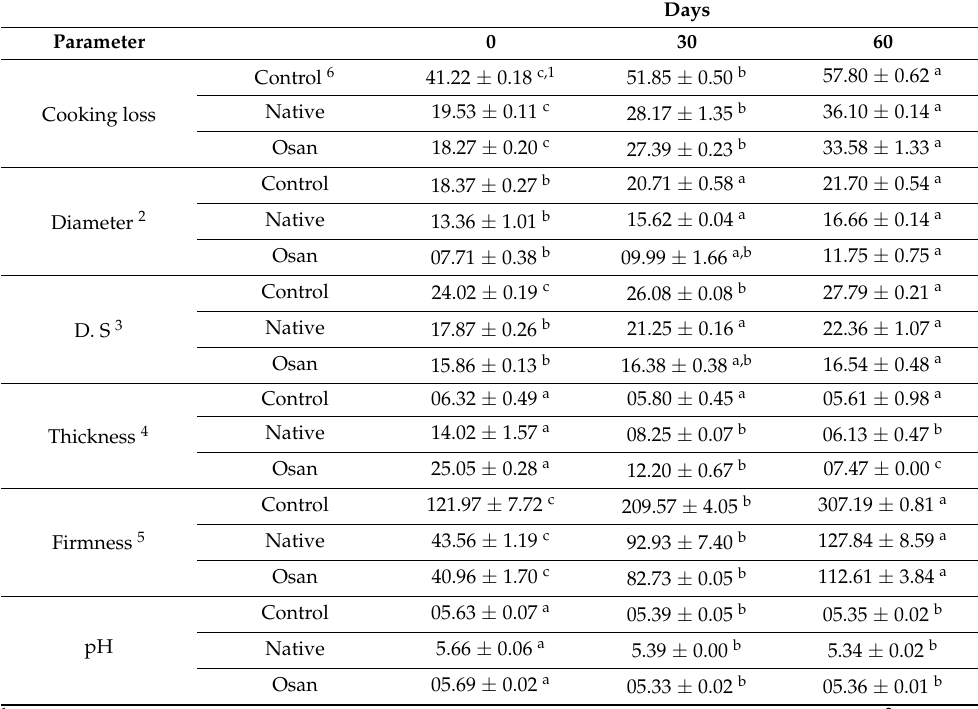
Table 2. Effect of 5% octenyl-succinylated (Osan) corn starch, native starch, and animal fat on the physiochemical characteristics of meat patties after storage at − 20 ◦ C for 0, 30, and 60 days.